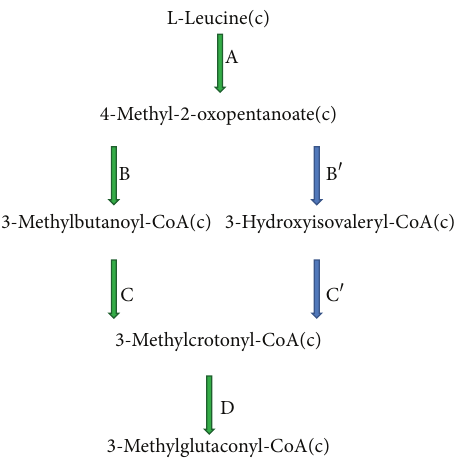
Figure 5: Leucine degradation pathway. The path in which the arrows are green is present in the model, while the path which includes 3-hydroxyisovaleryl-CoA is suggested by the experimental